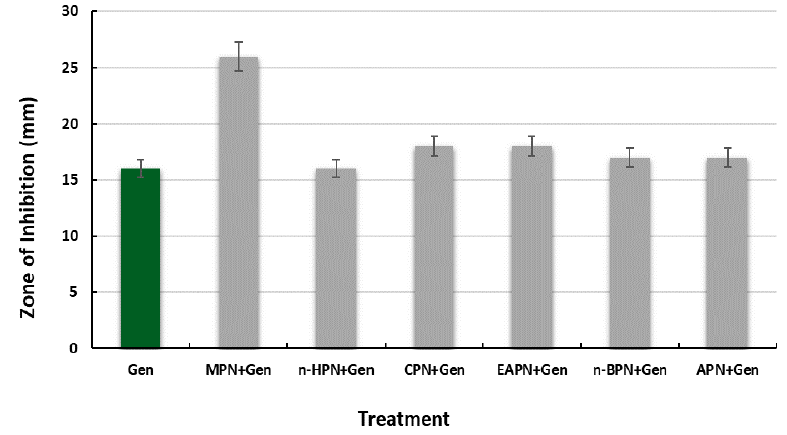
Figure 9. Antibiotic reversal activity of P. nigrum extracts in combination with amikacin (30 μg) for S. typhi.